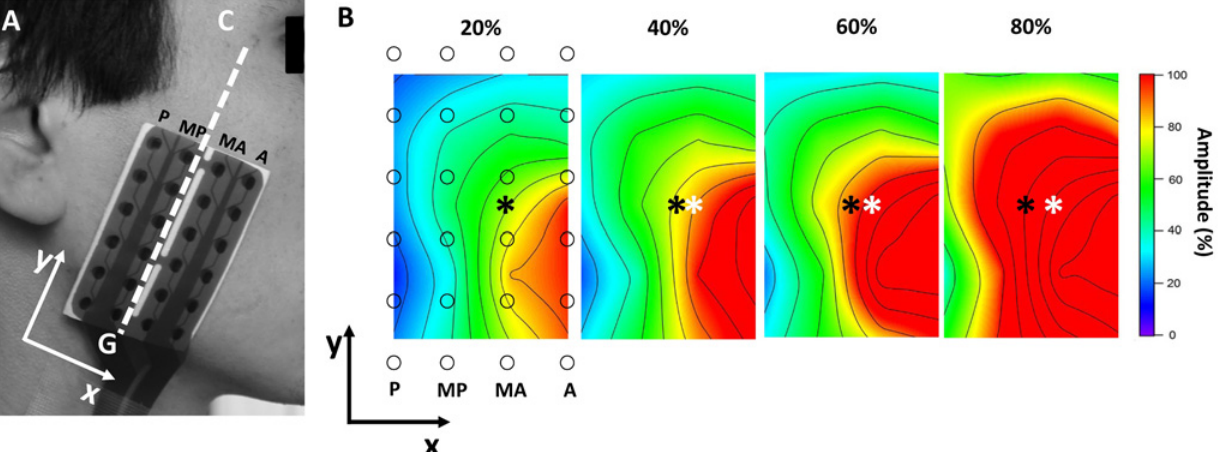
Figure 2. Show the matrix of electrodes used and the topographic maps of the amplitude of the EMG activity of the superficial masseter. (A) Matrix of 24 surface electrodes arranged in four columns: anterior (A), middle-anterior (MA), middle-posterior (MP) and posterior (P) columns. C: cantus, G: gonion. (B) Examples of topographic maps of the amplitude of the EMG activity of the superficial masseter recorded during bites at 20, 40, 60 and 80% of voluntary maximum bite force (VMBF). Maps were constructed in windows of 500 ms and with an interpolation factor of 8. Amplitude values of each map are expressed as a percentage of the maximum value of each one. (cid:1) : electrode positions. * : location of center of mass. * : location of center of mass at 20% of